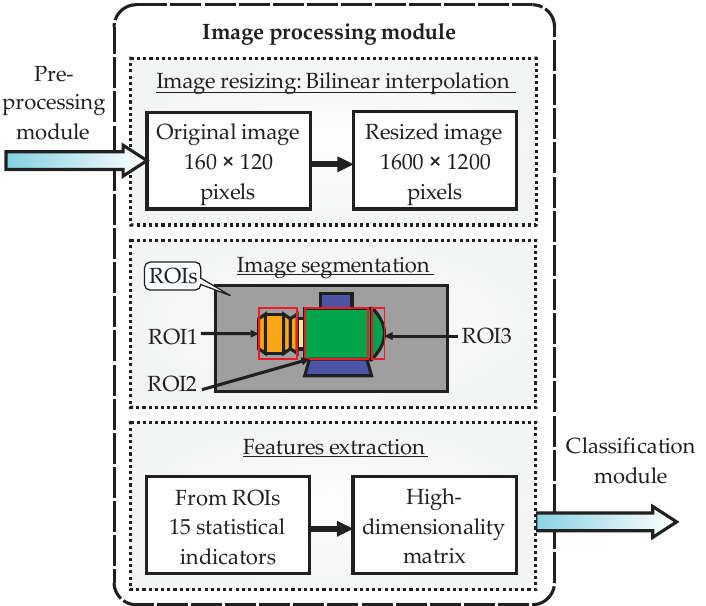
Figure 5. Block diagram of the image processing module in the smart sensor.